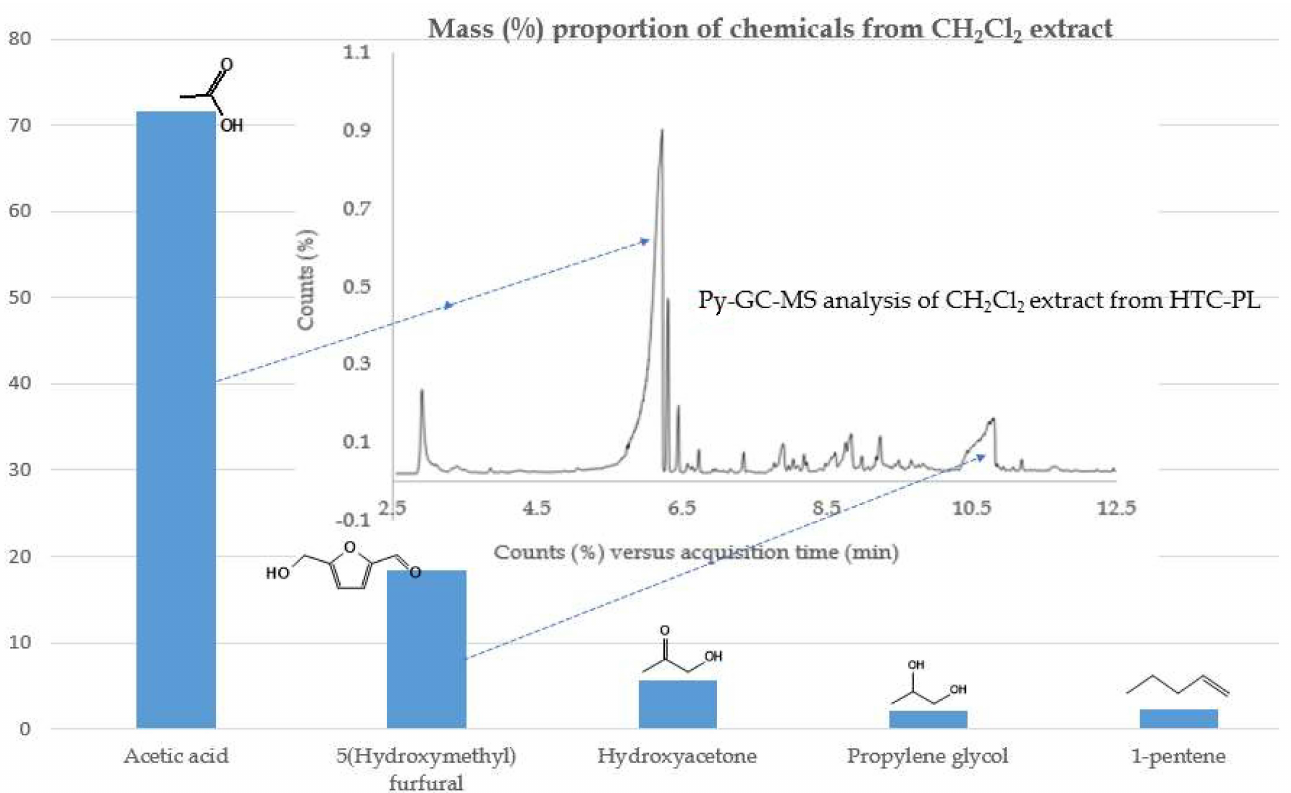
Figure 5. Major chemicals in methylene chloride extracts from HTC-PL as identified by GC-MS.